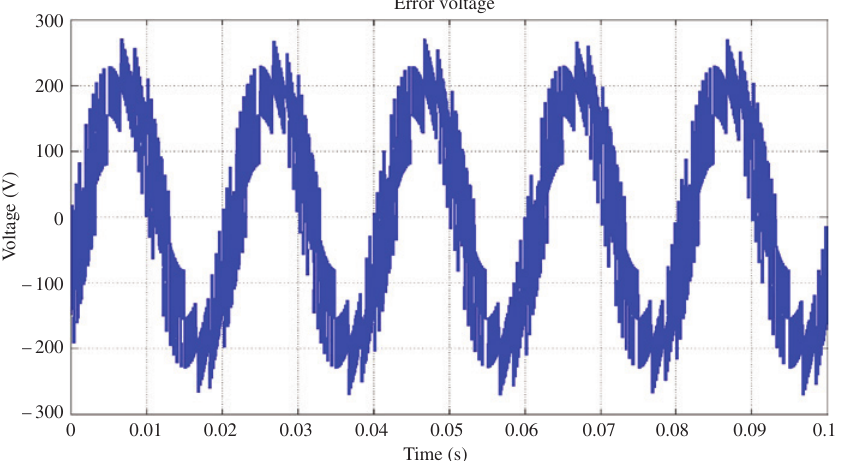
Figure 7: Difference between Normal Output and Reference Voltage.